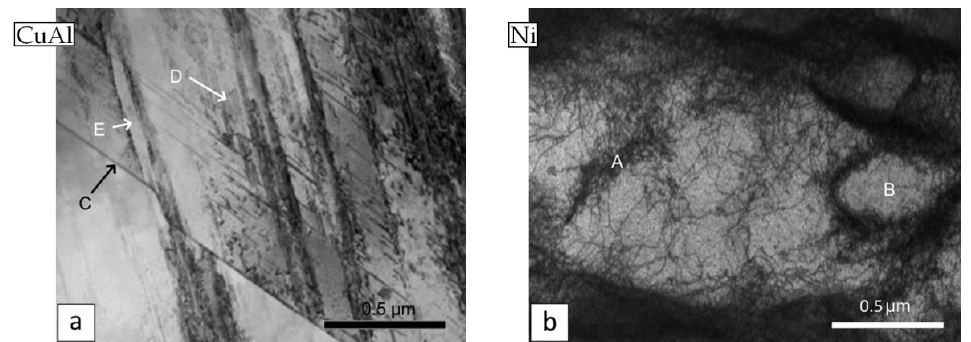
Figure 8. ( a ) Deformation twins and stacking faults in CuAl alloy and ( b ) dislocation cells in nickel using transmission electron microscopy: A — cell wall; B — sliding dislocation; C — microtwin; D — stacking fault; and E — microband.